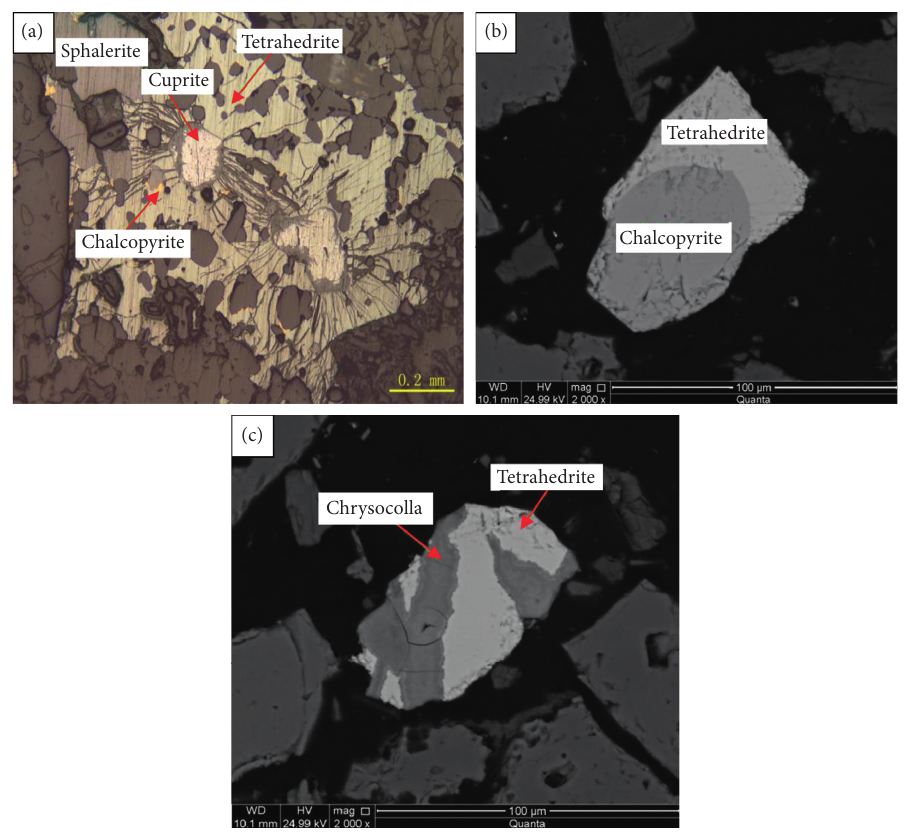
Figure 5: Embedded characteristics of